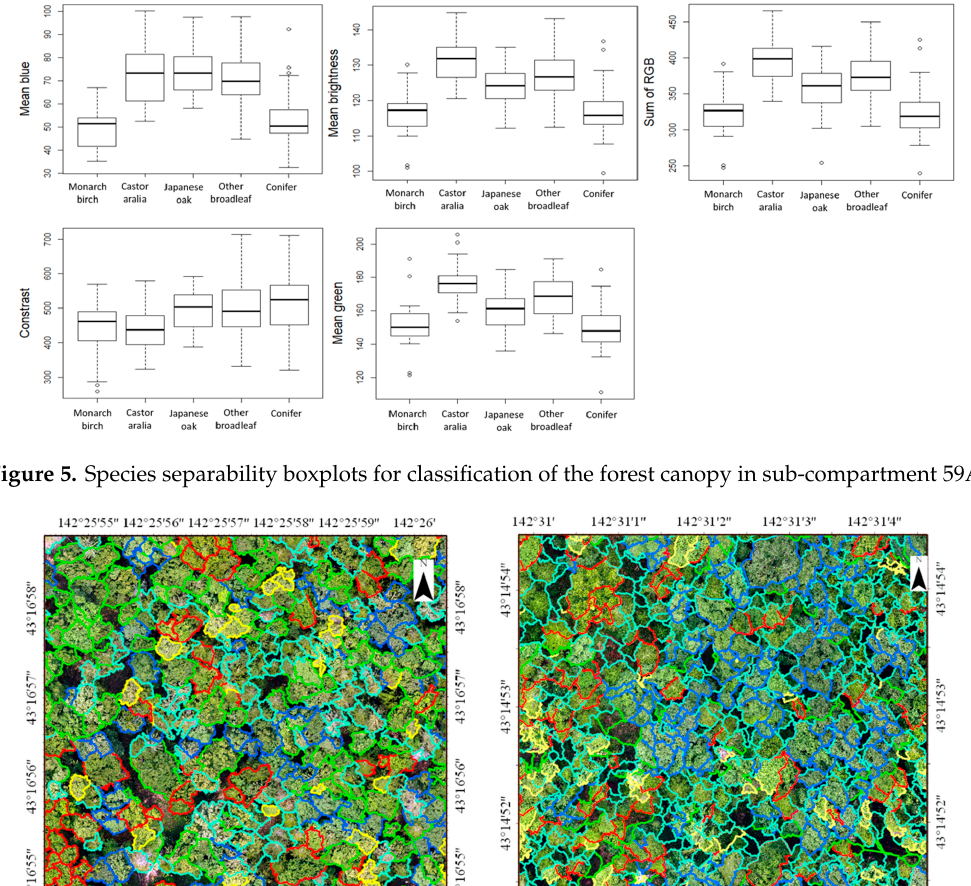
Figure 4. Species separability boxplots for classification of the forest canopy in sub-compartment 36B.